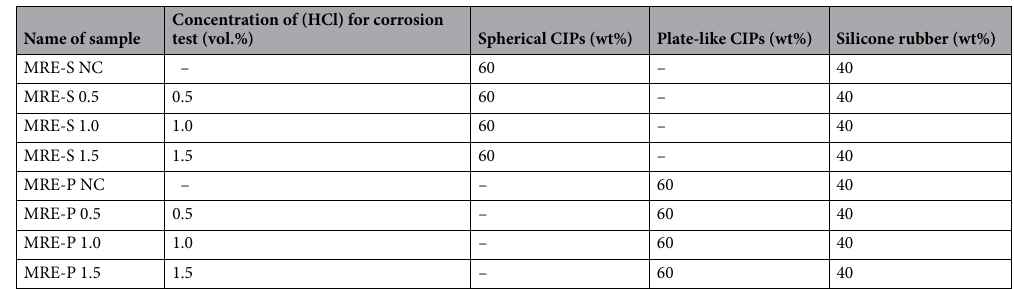
Table 1. Compositions of MREs.